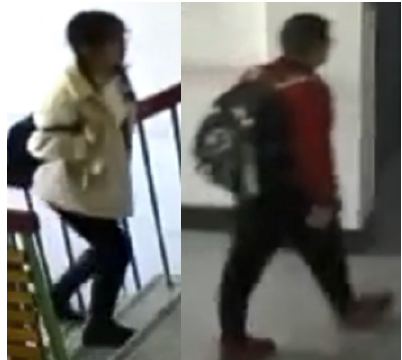
Figure 5. The images of pedestrians to be detected, from left to right, are named bag,